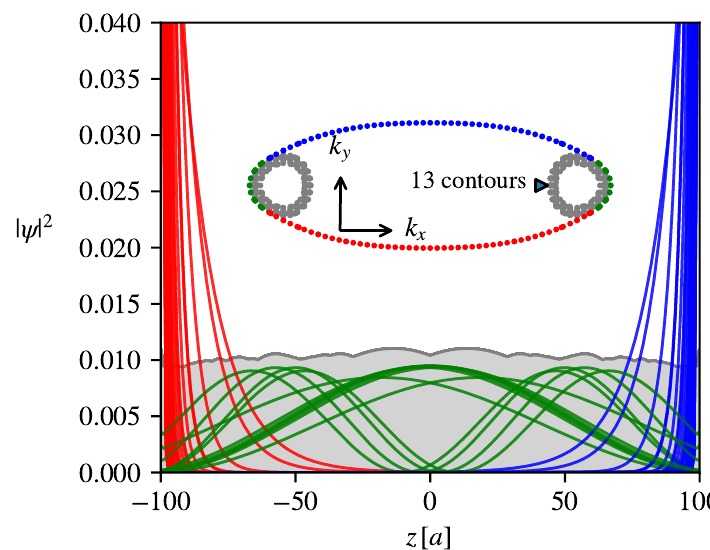
Figure 2: Position- z -resolved probability density | ψ | 2 = |〈 z | ψ 〉| 2 of Fermi-level states. Colors indicate surface states at the lower boundary (red) and upper boundary (blue), the confinement-induced chiral bulk states (green), and normal bulk states (gray). = 0.3 t , W = 201, µ = 0.3 t E F b